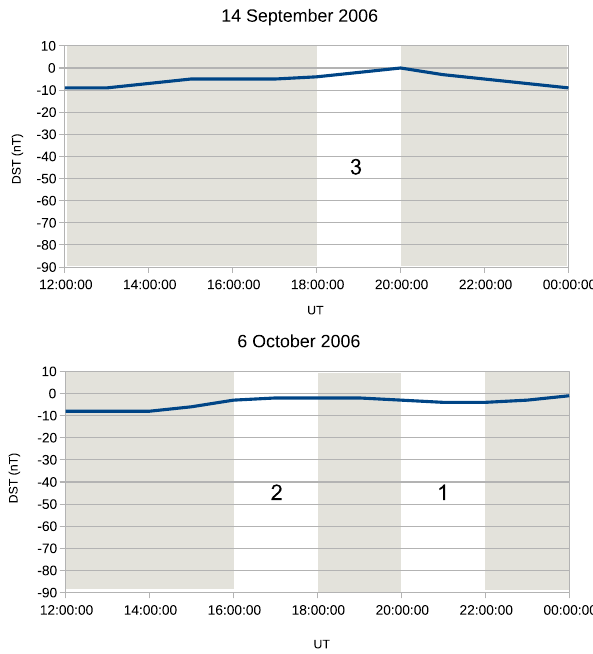
Figure 12. DST during the periods of interest. The labelled, un- shaded portions represent the three events studied.